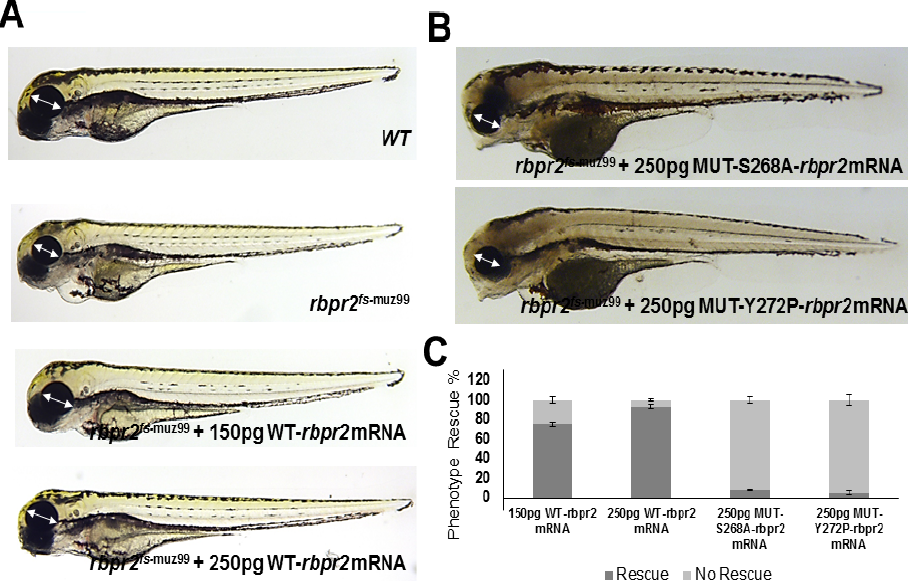
Figure 10. WT- rbpr2 mRNA rescues the rbpr2 fs-muz99 mutant phenotype. ( A ) Rescue experiments were performed by injecting WT zebrafish rbpr2 mRNA into control and rbpr2 fs- muz 99 mutant embryos at the